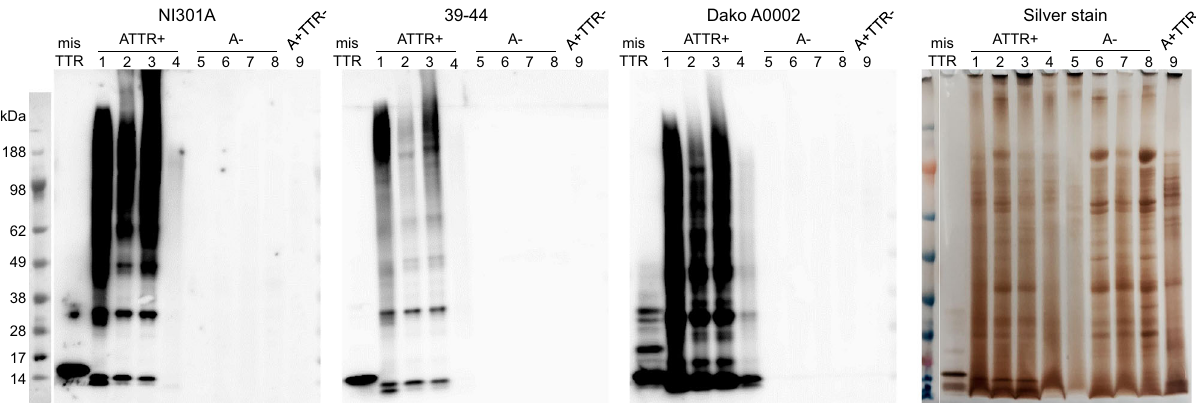
Fig. 3 NI301A binds small and large ATTRwt aggregates extracted from patient tissues. Semi-native SDS-PAGE analysis of the amyloid fi bril extracts prepared from frozen post-mortem cardiac tissues presenting TTR amyloid (ATTR + samples, #1 – 4), no amyloid (A − samples, #5 – 8), or non-TTR amyloid (A + TTR − sample, # 9). Identical SDS-PAGE gels were processed for western blot analysis with the antibodies NI301A, 39-44, and Dako A0002, or stained with the silver method. The low ATTR staining intensity of sample 4 is consistent with the low amount of TTR amyloid observed by IHC in